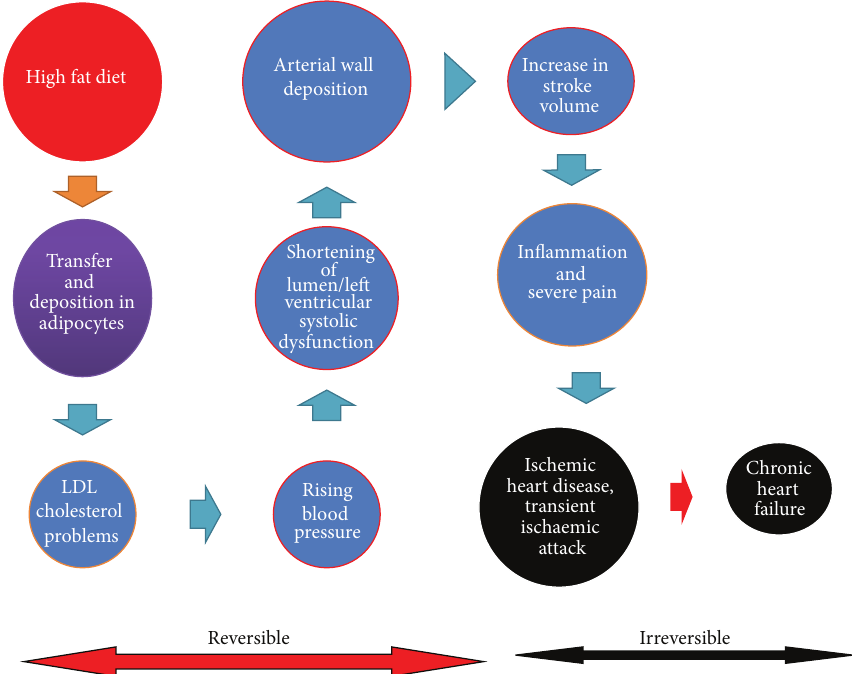
Figure 4: Showing successive progression of transient ischemic attack and chronic heart failure in